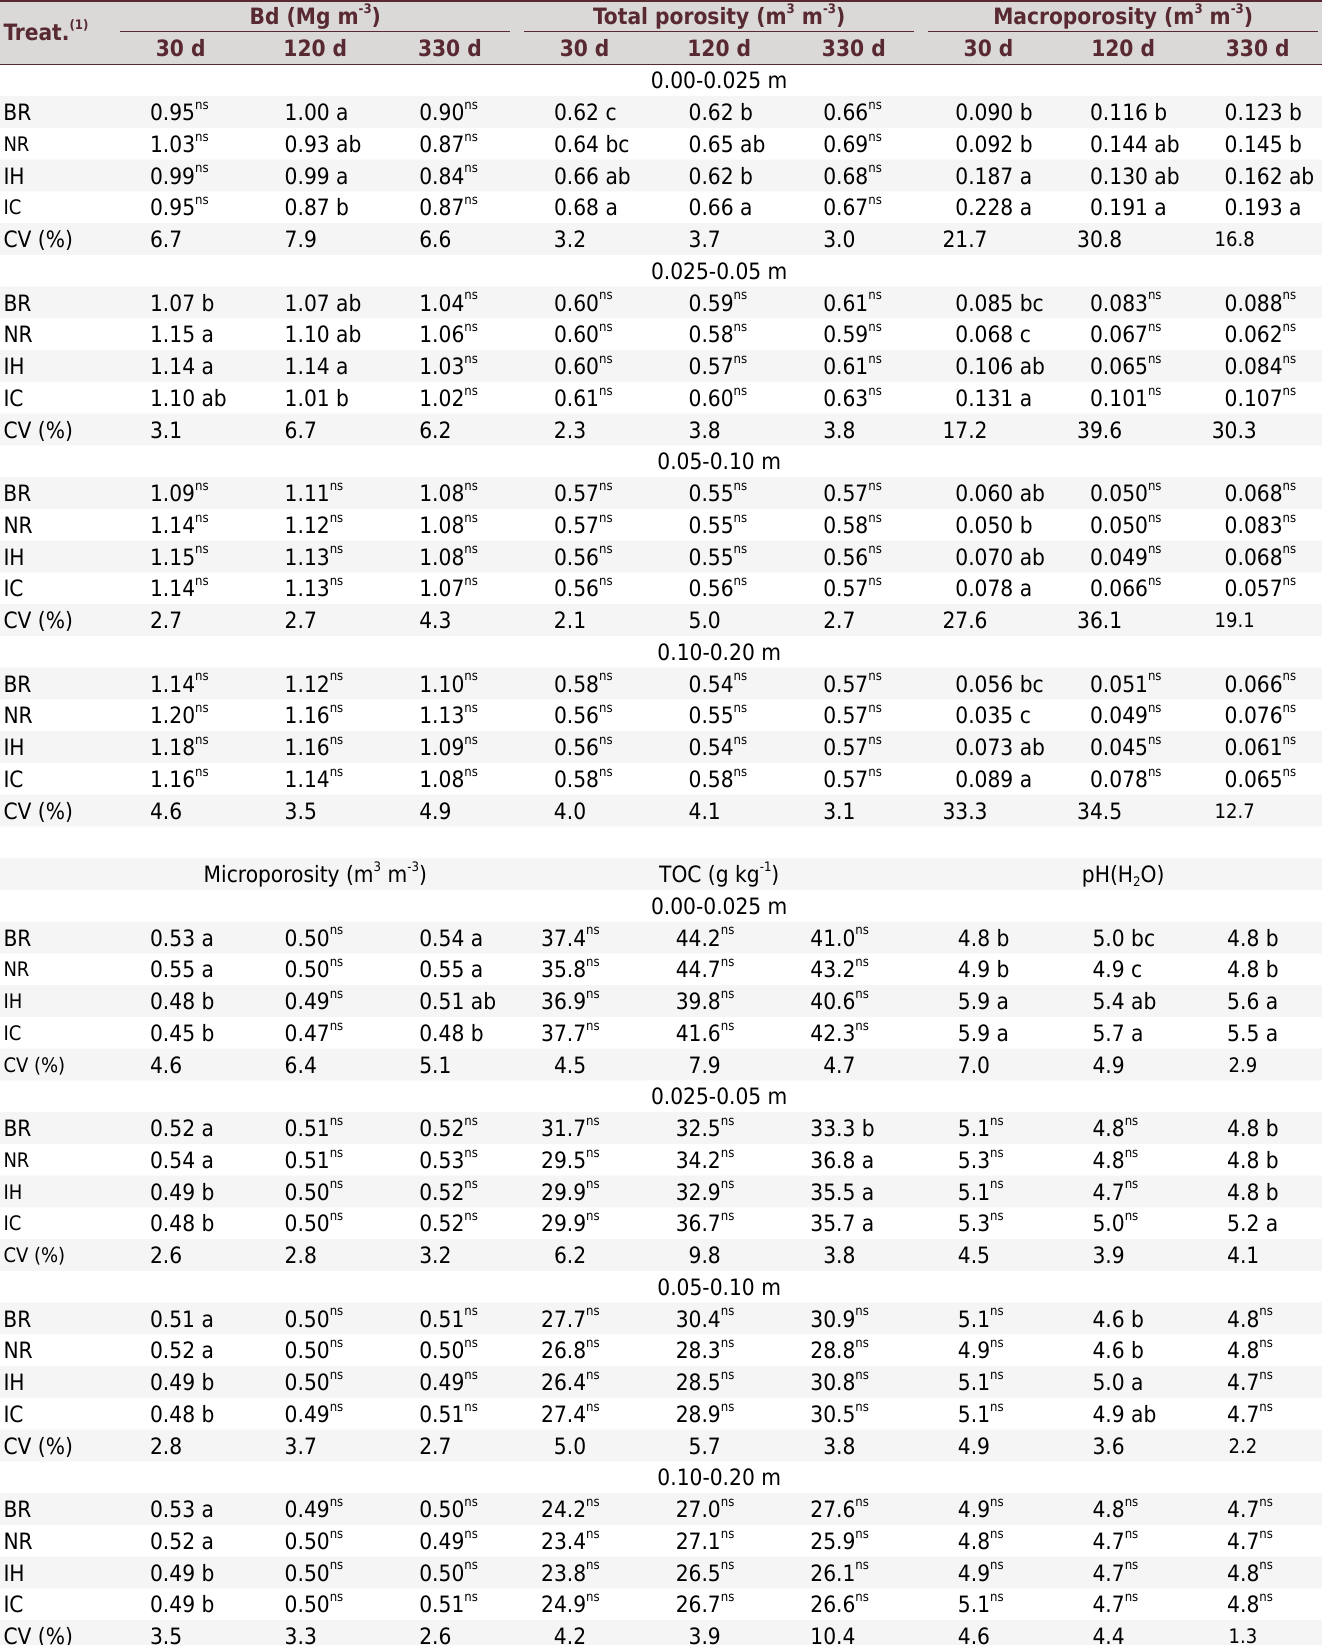
Table 2. Soil bulk density (Bd), total porosity, macroporosity, microporosity, total organic carbon (TOC), and soil pH, in four layers for the different treatments and evaluation periods (30, 120, and 330 days) Treat.